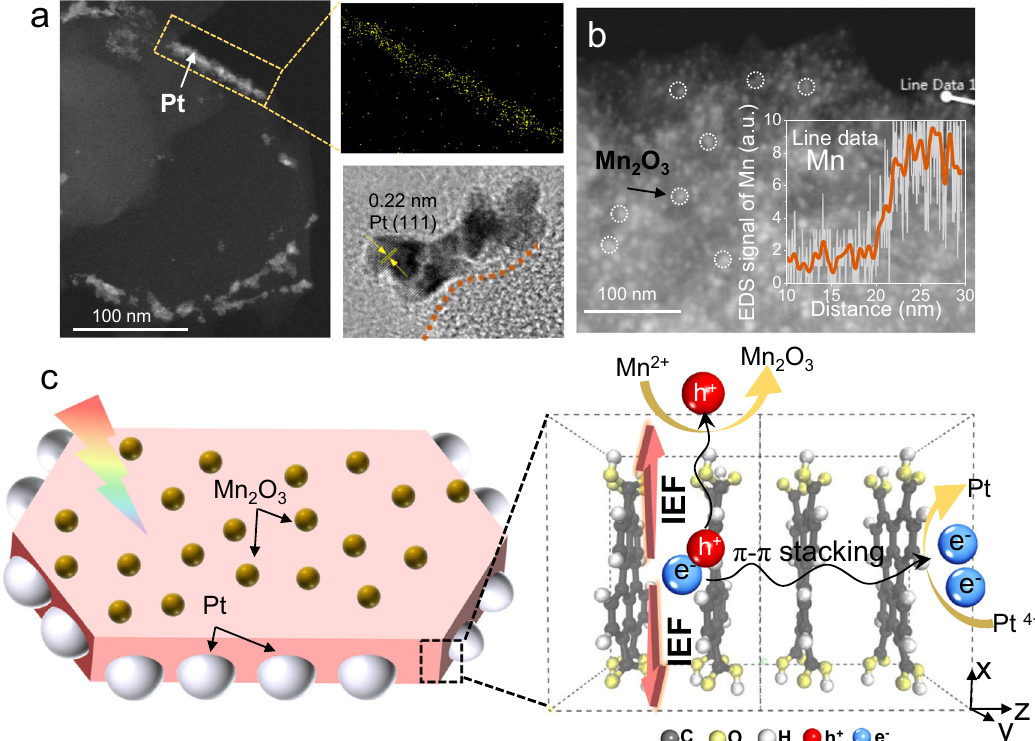
Fig. 5 Anisotropic migration of photogenerated carriers. ADF-STEM photodeposition on PTA with a Pt and high resolution and mapping, b Mn 2 O 3 (inset: Mn element liner scan). c Schematic illustration of Pt and Mn 2 O 3 photodeposition on PTA under visible light ( λ ≥ 420 nm). Deposition method: 10 mg of PTA was dispersed in 100 mL of deionized water, and 4 wt. % H 2 PtCl 6 (weighed by Pt) or 5 wt. % MnCl 2 (weighed by Mn) was added and exposed to visible light ( λ ≥ 420 nm) for 3